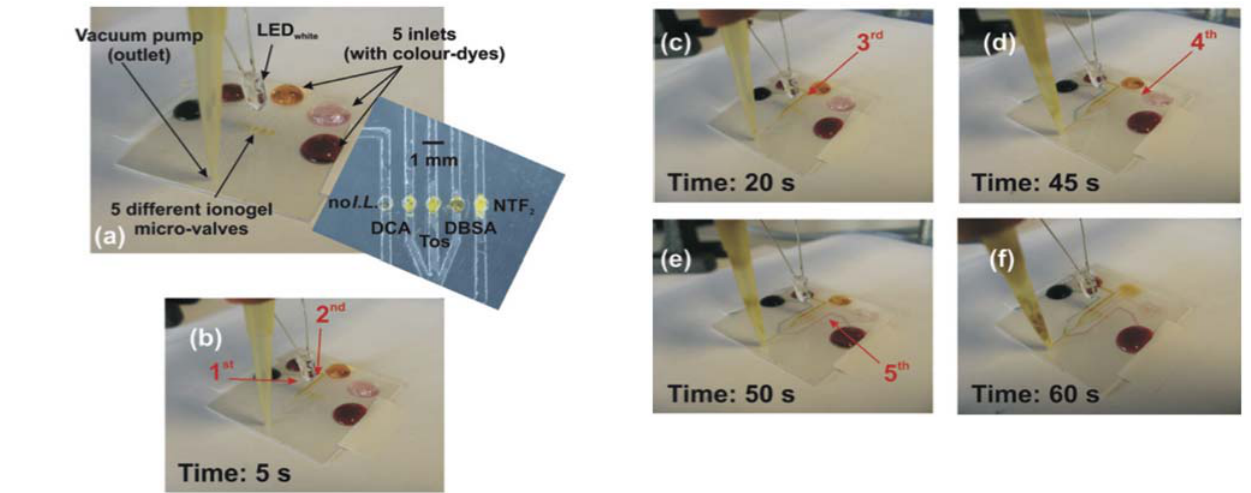
Figure 5. Overview of the photo-responsive ionogels: (a) micro-valves closed; the applied vacuum is unable to pull the dyes through the micro-channels; (b) white light is applied for the first time; (c)–(f) controlled fluidic flow as a function of the IL anion in the ionogel [18] (Reproduced by permission of The Royal Society of